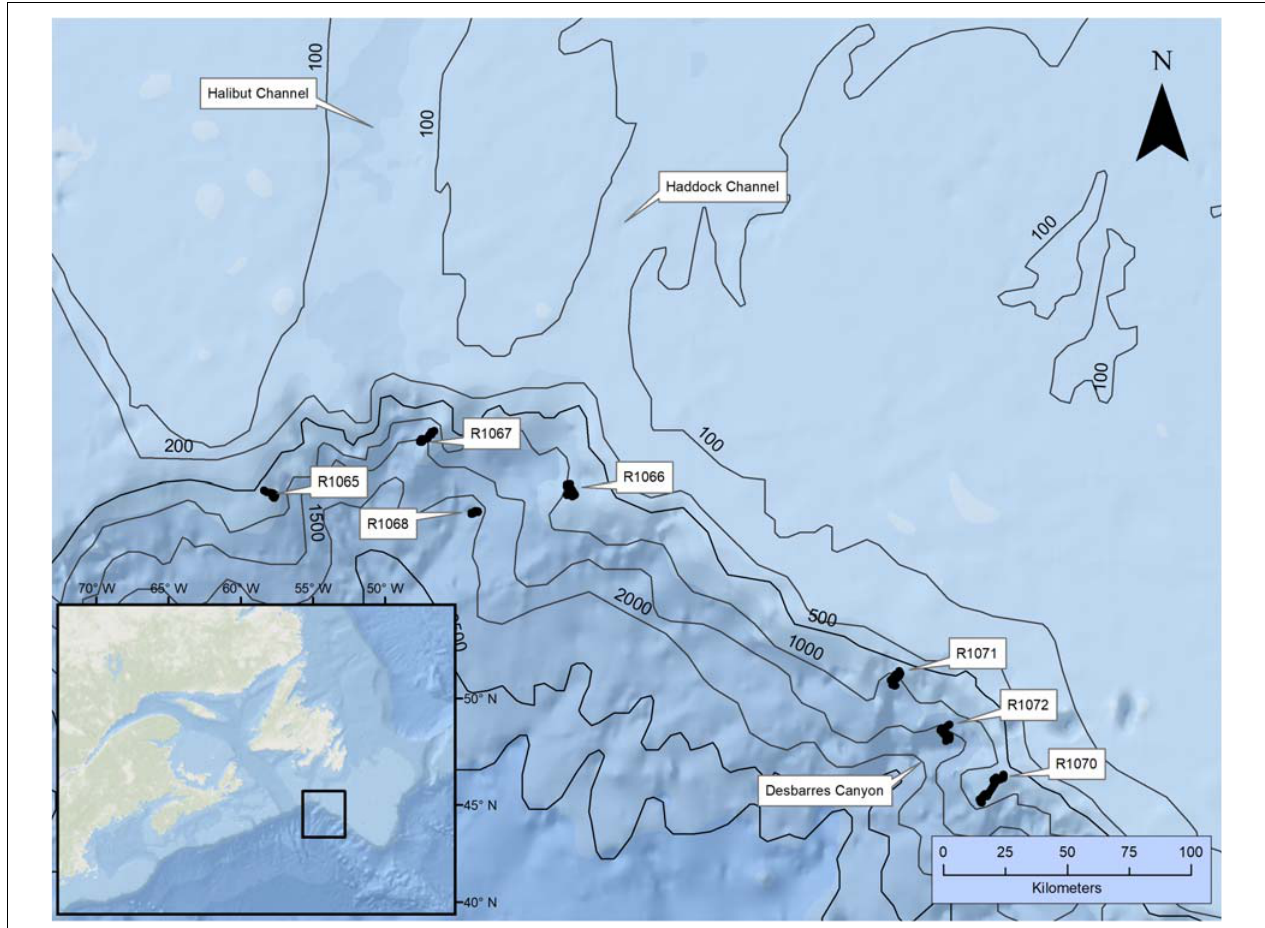
FIGURE 1 | Locations surveyed using the remotely operated vehicle, ROPOS. Individual dive numbers and canyons of interest are